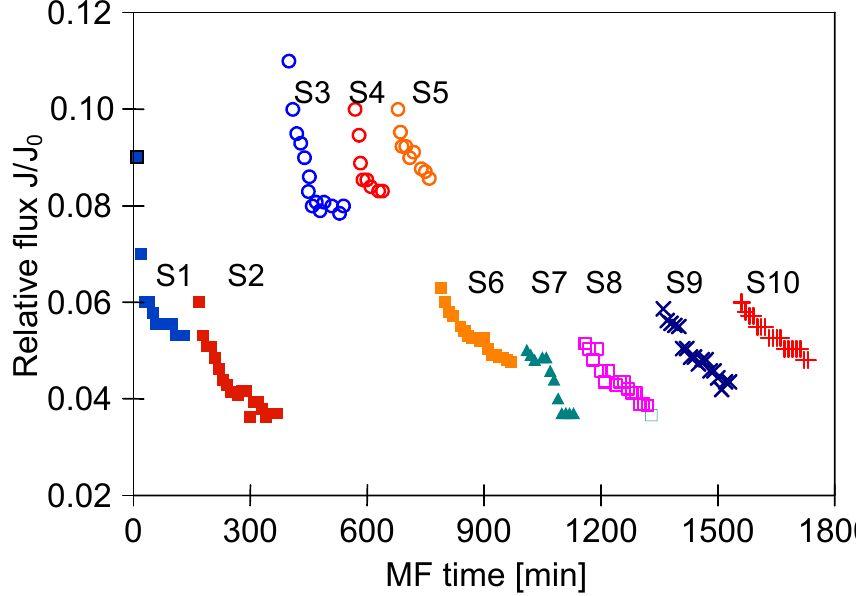
Figure 18. Changes in relative permeate flux during the long-term MF process of yeast suspension. Module M3, TMP = 0.08 MPa, V F = 5.5 m/s.